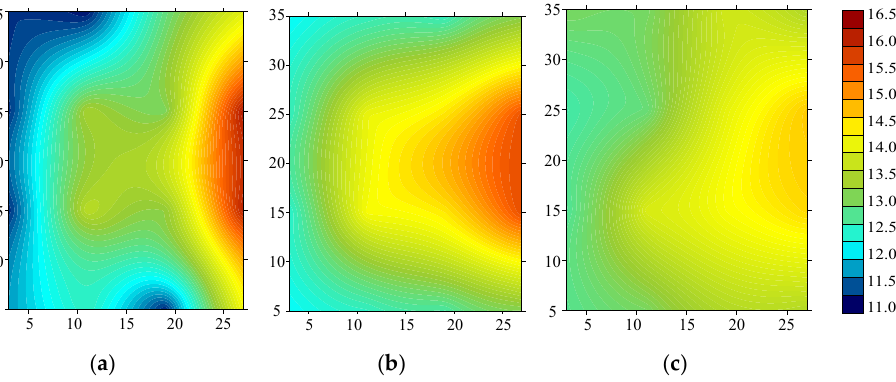
Figure 6. Dynamic distribution of pressure field in soaking of case one: ( a ) soaking for 10 min; ( b ) soaking for 5 h; ( c ) soaking for 10 h.